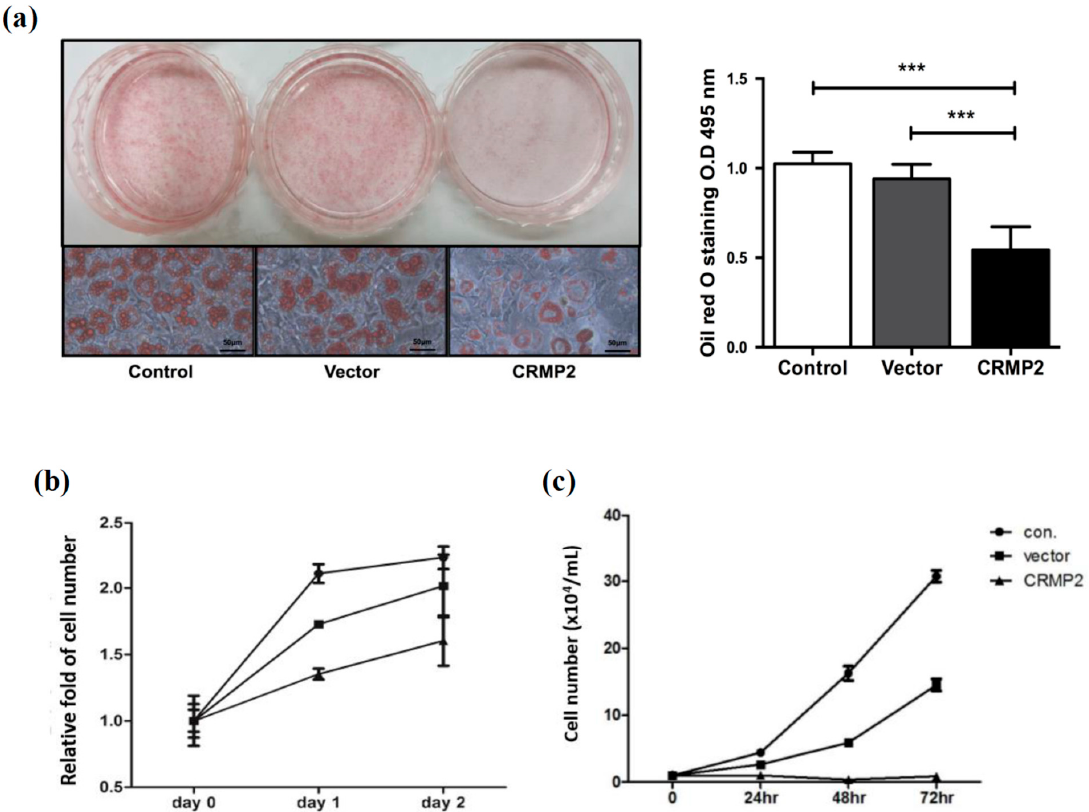
Figure 2. CRMP2 overexpression inhibits adipocyte differentiation and cell proliferation at mitotic clonal expansion (MCE) phase. Pre-adipocytes were transfected with either CRMP2-expressing or control vector on day-2, then allowed to enter differentiation. ( a ) Lipid contents in the mature adipocytes with CRMP2 overexpression (CRMP2-cells), control vector (Vector) and the mock transfection (Control) were measured by Oil-Red O staining on day 8. The images were taken using the Nikon ECLIPSE TS100 microscope with 40× objective, scale bars = 50 μ m. ( b ) Cells in MCE phase were trypsinized and counted by trypan blue exclusion on the day indicated. ( c ) Pre-adipocytes were transfected with either CRMP2-expressing or control constructs, then trypsinized and counted on the indicated time without MDI induction. The data were presented as the mean ± SEM, and statistically analyzed by one-tailed unpaired Student t- test ( n = 3). *** p < 0.005.